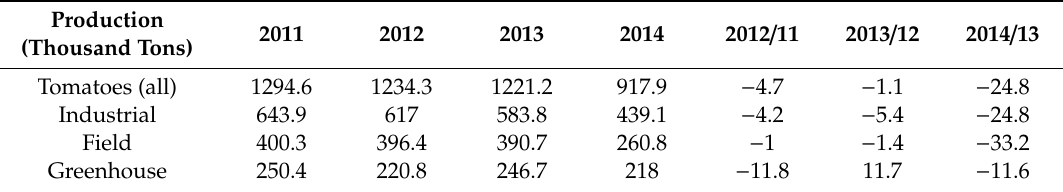
Table A1. Tomato production volume. Source: ESTAT